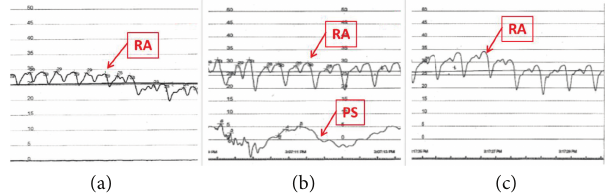
Figure 2: Hemodynamics noted during the right heart catheteri- zation. (a) Elevated right atrial (RA) pressure showing respiratory variations. (b) Elevated RA pressure despite decreased pericardial space(PS)pressureimmediatelyafterevacuationofpericardialfluid. (c) Elevated RA pressure despite full evacuation of fluid.